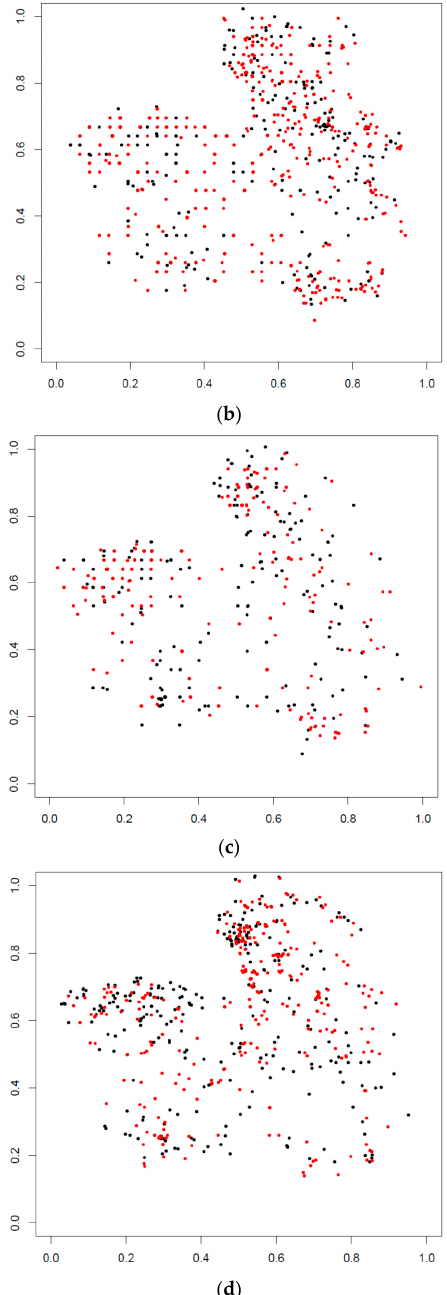
Figure 2. Spatial distribution of the actual HFC events compared: ( a ) year 2004; ( b ) year 2005; ( c ) year 2006; and ( d ) year 2007. In any case, those events corresponding to period 1 are in black and those events corresponding to period 2 are in red.